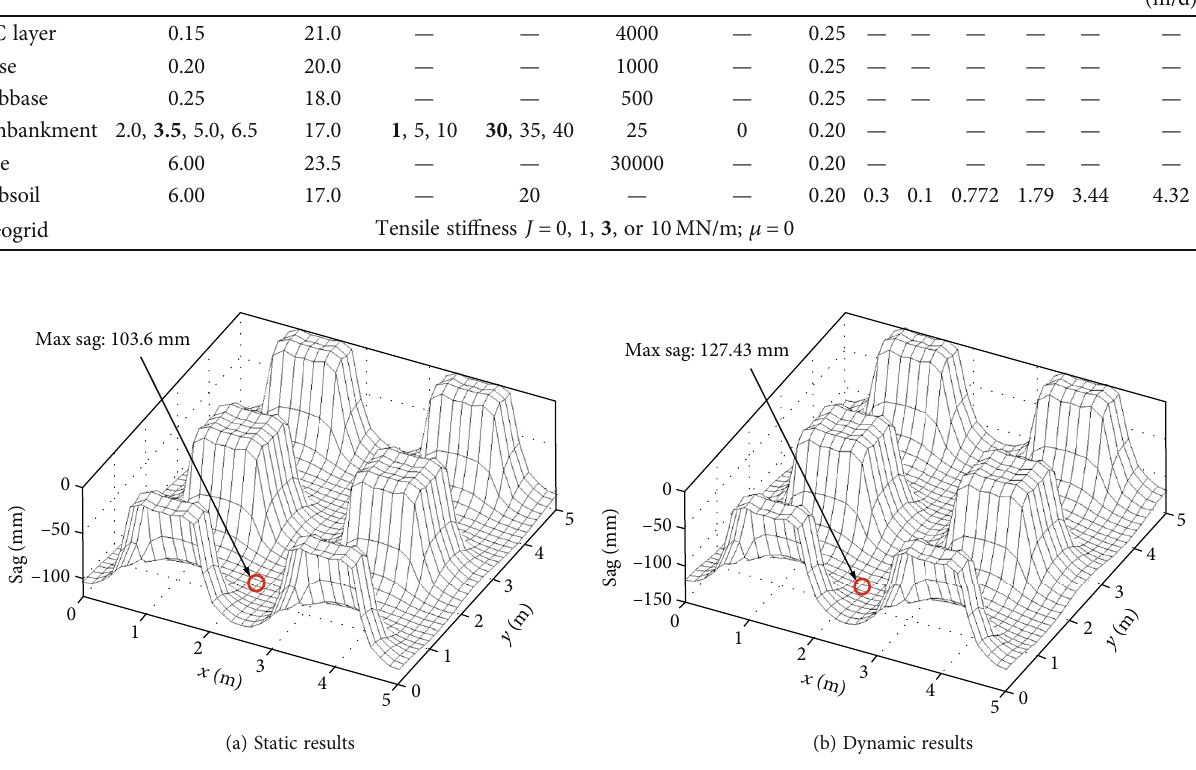
Figure 2: Sag of the geogrid ( s = 2 : 5 m, h = 3 : 5 m, J = 3 : 0 MN/m, υ = 60